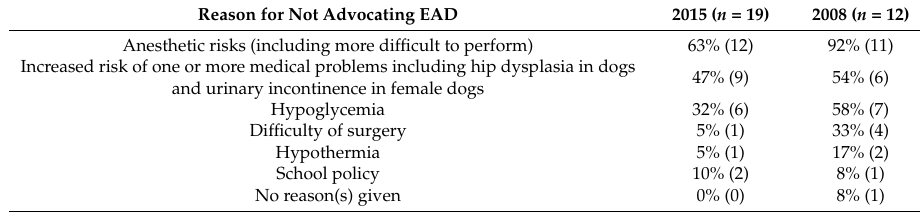
Table 5. Reasons university veterinary teaching staff from Australia and New Zealand in 2008 and 2015 did not advocate early age desexing: the percentages (and numbers) of respondents nominating each response within each year are shown, expressed as percentages of those answering ‘no’ or ‘yes and no’ to the question ‘In your teaching of desexing to students of both female and male cats and dogs, are you advocating the use of EAD?’. Each respondent could nominate multiple